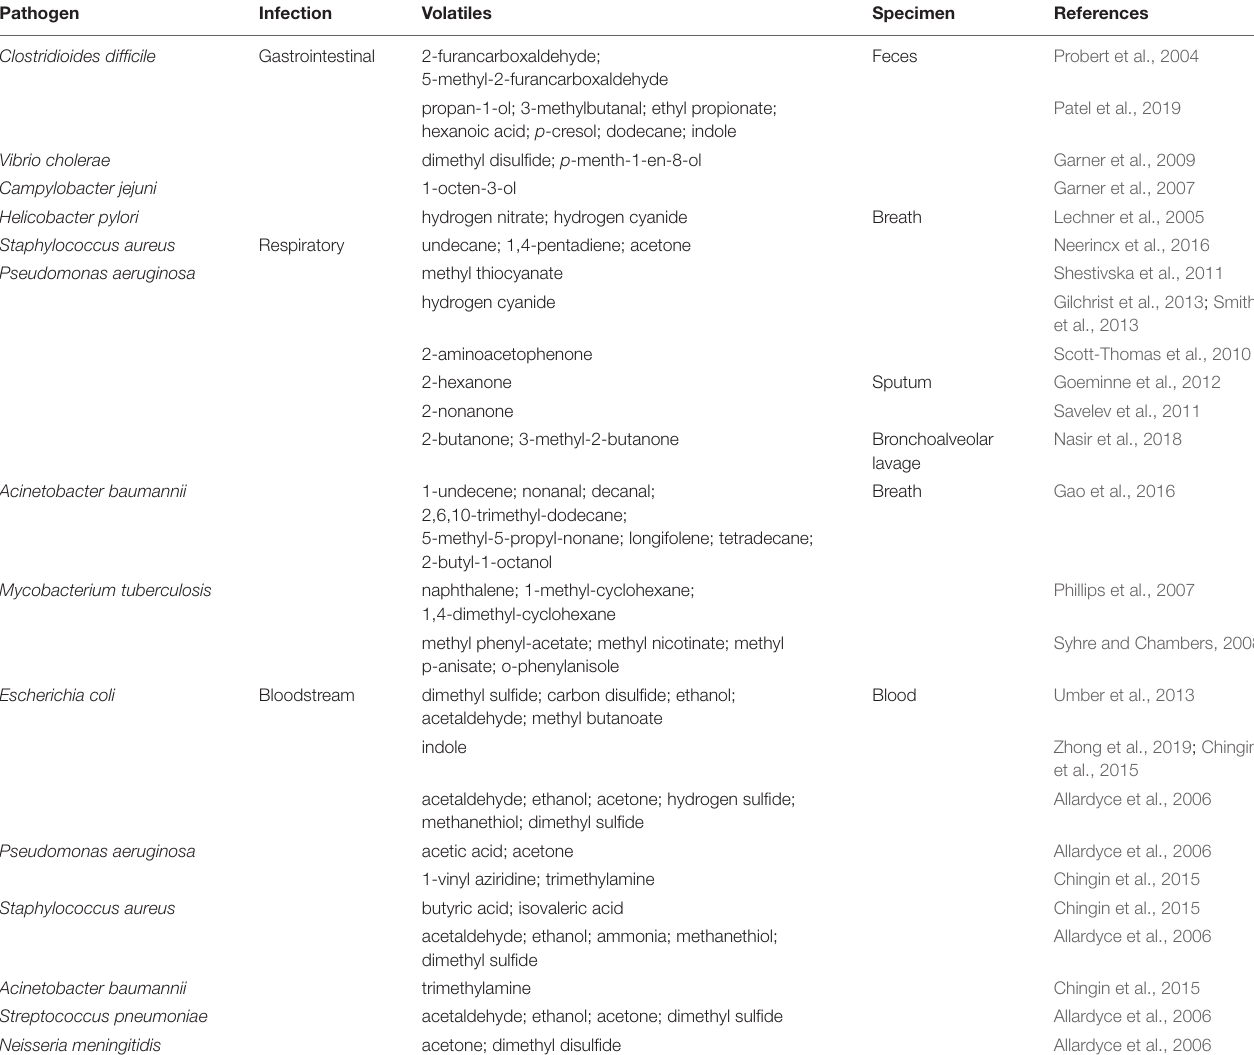
TABLE 1 | A summary of identified volatiles for each pathogen and type of